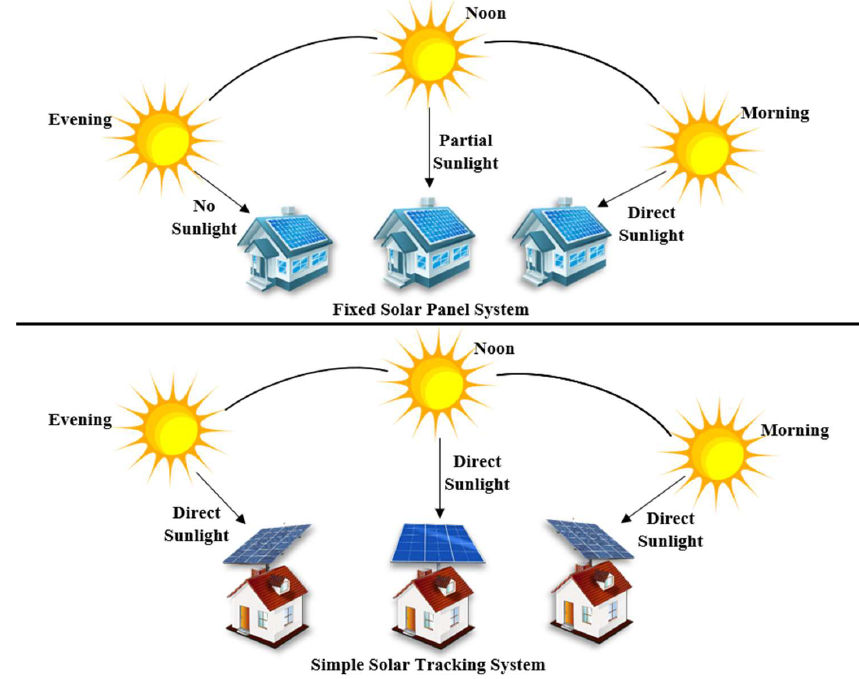
Figure 1. Comparison between Fixed and Simple Solar Tracking Systems.